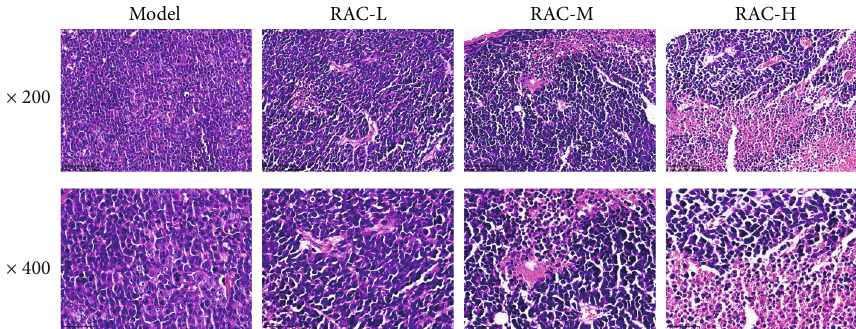
Figure 4: RAC-damaged tumor cell in RCC mice. The pathological changes were evaluated by HE. All the pictures were original magnification × 200 or × 400. n = 3 . Note: HE: hematoxylin and eosin; RAC: Radix Actinidia chinensis; RCC: renal cell